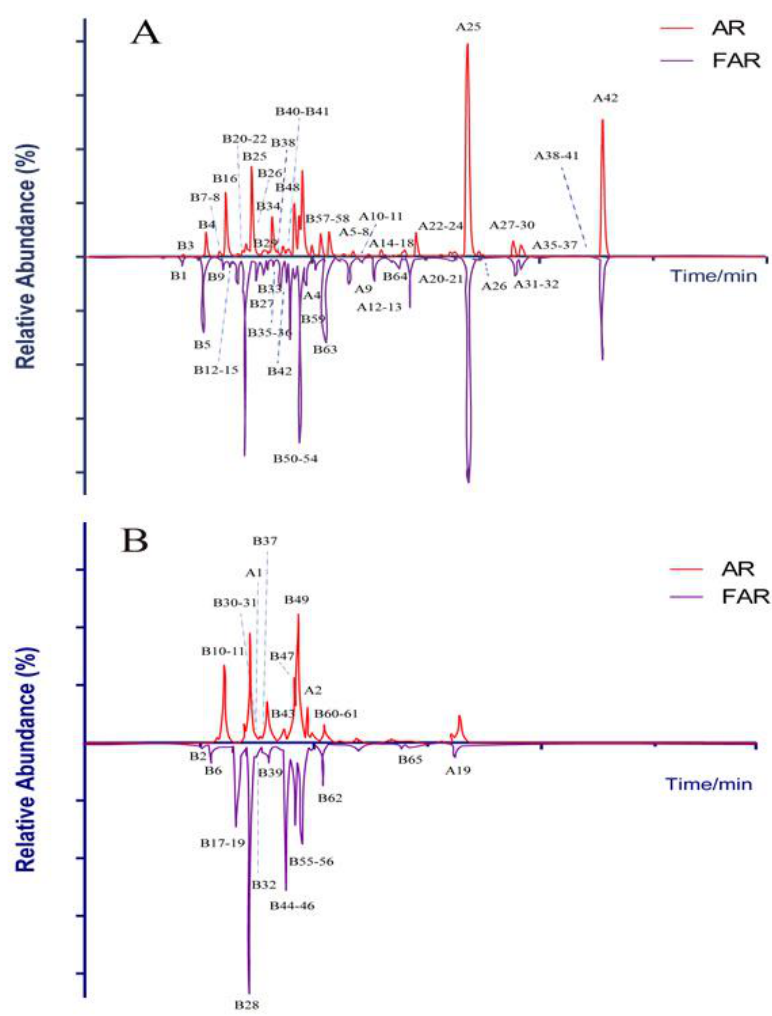
Figure 2. High-resolution extracted ion chromatograms for 107 compounds in AR and FAR. ( A ) Results of negative ion mode; ( B ) results of positive ion mode.